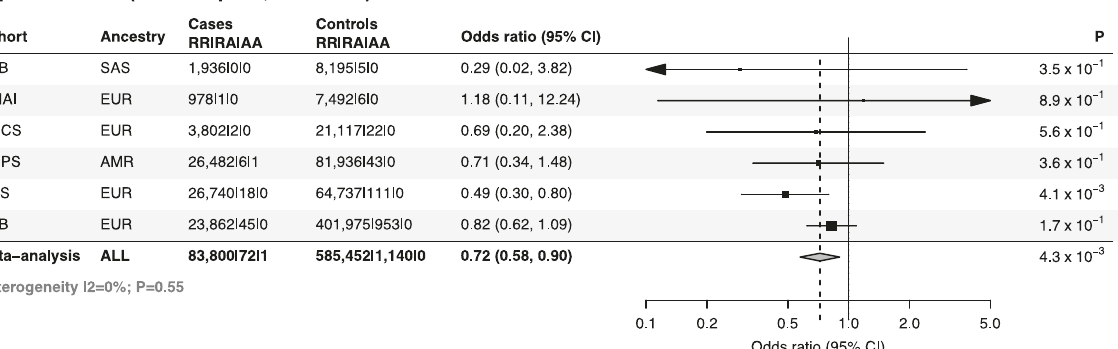
Fig.5|Associationof INHBE pLOFvariantswithfavorablemetabolicpro fi leand protection from type 2 diabetes. A shows associations with anthropometric and metabolic phenotypes, including 645,626 individuals. P -values are from two-sided Wald tests. Markers represent estimated beta coef fi cients, while error bars repre- sent 95%con fi denceintervals. B shows ameta-analysis of the associationwith type 2 diabetes risk, including a total of 83,873 cases and 586,592 controls. P-values are from two-sided Wald tests. Markers represent estimated odds ratios, while error bars represent 95% con fi dence intervals. The gray diamond represents